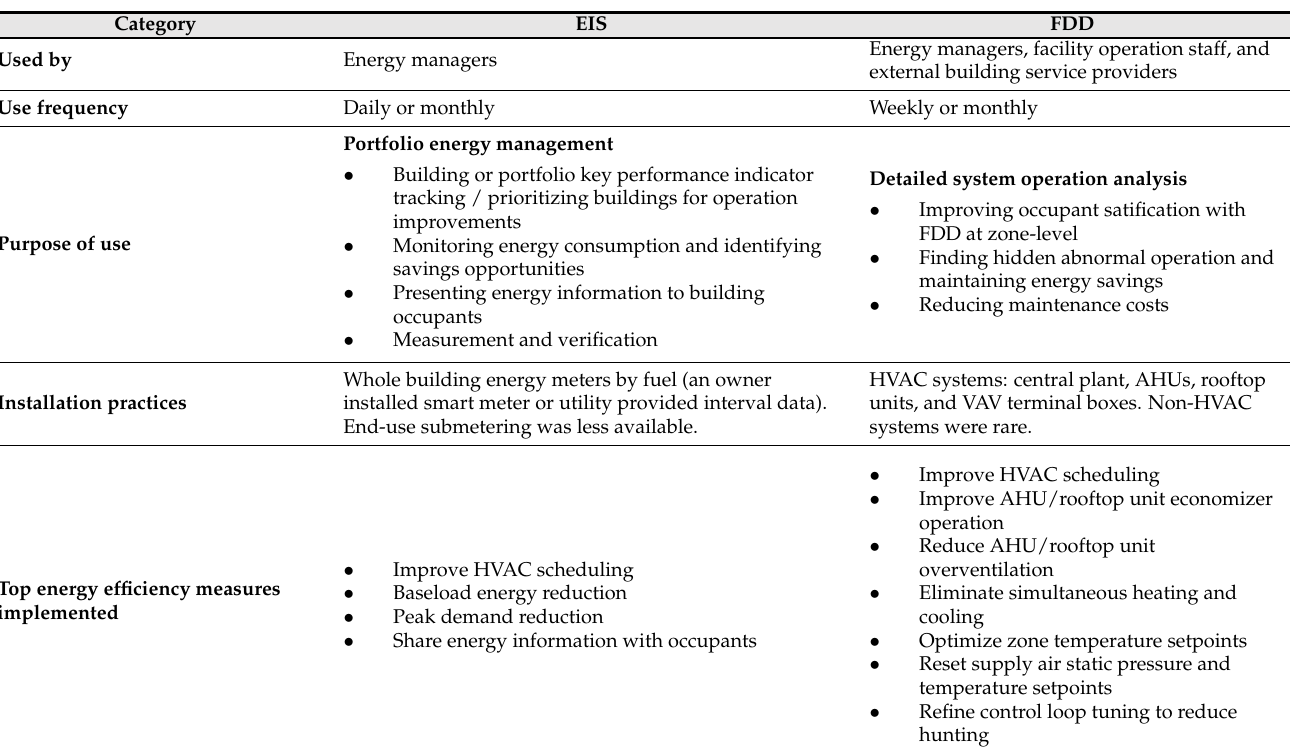
Table 5. Summary of building analytics tool use in commercial buildings.